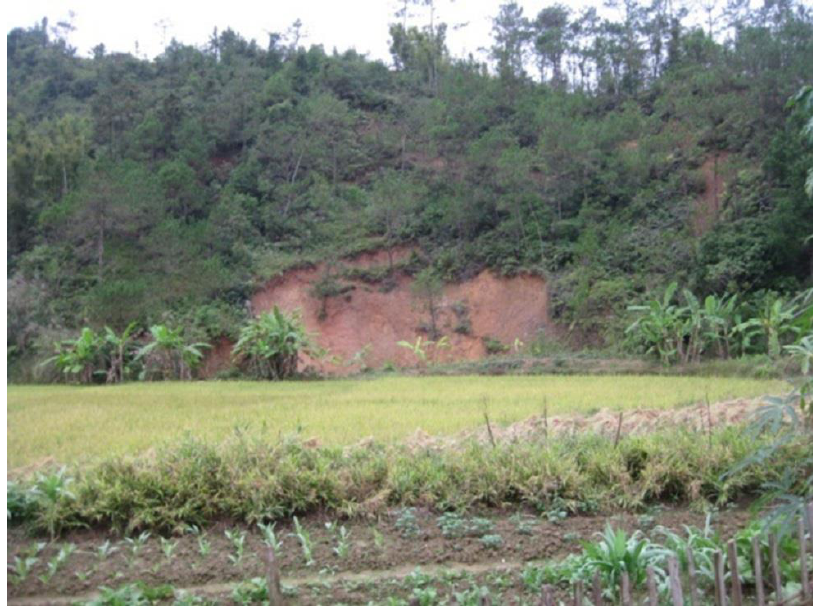
Figure 13. Landslide failure of a slope on expressway C, Guangdong, China.